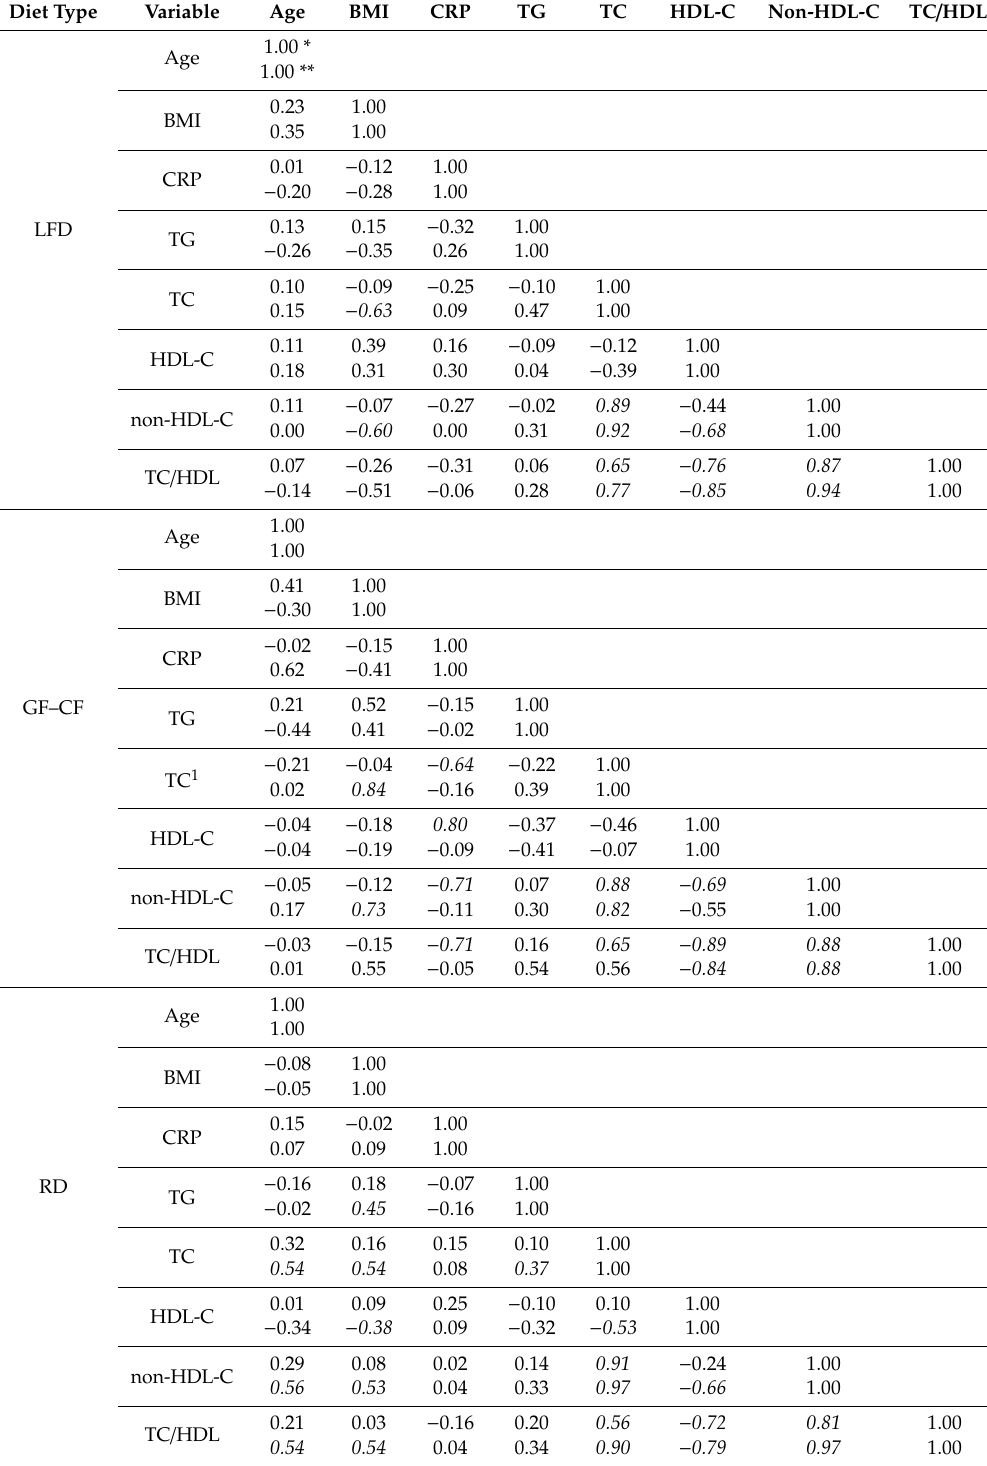
Table 3. Spearman correlation coe ffi cient matrix between age, BMI, CRP and lipid profile determined in investigated patients and healthy volunteers according to first and second assessment period and type of